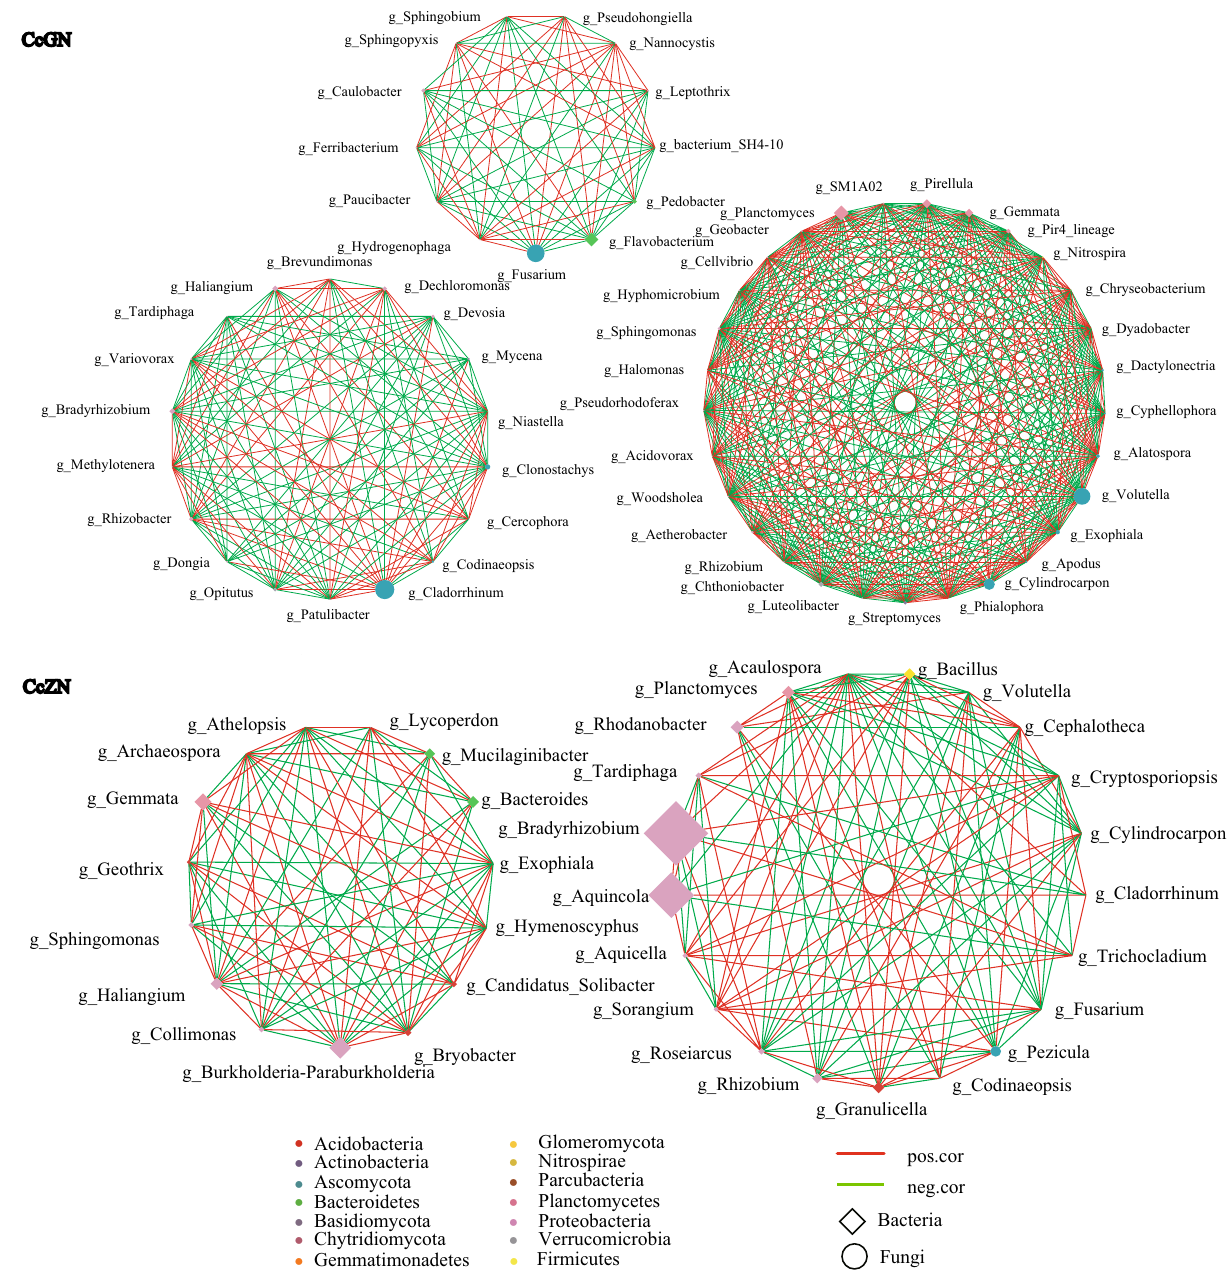
Figure 5. Microbial network in the endosphere of healthy and diseased Cc . The microbial network was constructed by Cytoscape 3.8.0. Microbial network in the endosphere of diseased Cc (CcGN), Microbial network in the endosphere of healthy Cc (CcZN). The co-occurrence network was inferred for each maternal sample type by a pairwise correlation of relative abundance for all genera. The elliptical and square node in the network indicates a fungal and bacterial genus, respectively. Node size represents the average relative abundance of one genus in each sample type. Nodes in different colour show genera belong to the phylum. Edge colour shows positive (red) and negative (blue) correlations,